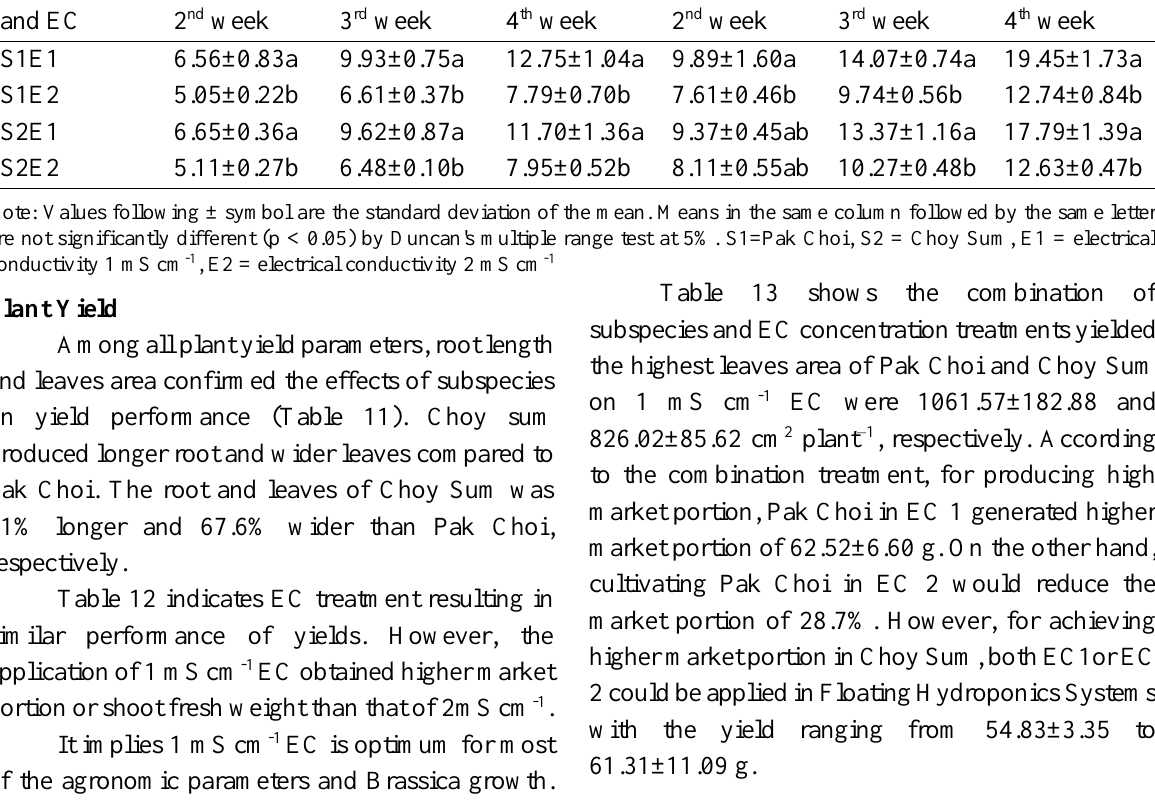
Table 10. Effect of combination of species and initial electrical conductivity on width and length of leaves Combination Leaves width Leaves s of species and EC